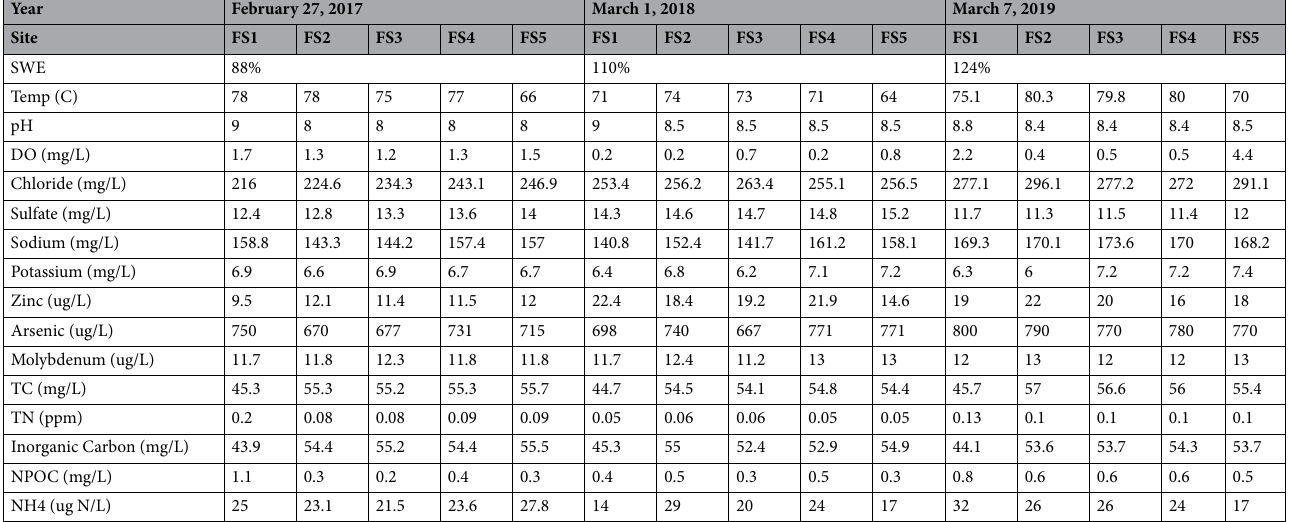
Table 1. Geochemical characteristics from 2017 to 2019. SWE denotes snow water equivalent percentage of the median for the previous year. DO dissolved oxygen. TC total carbon. TN total nitrogen. NPOC non- purgeable organic carbon.